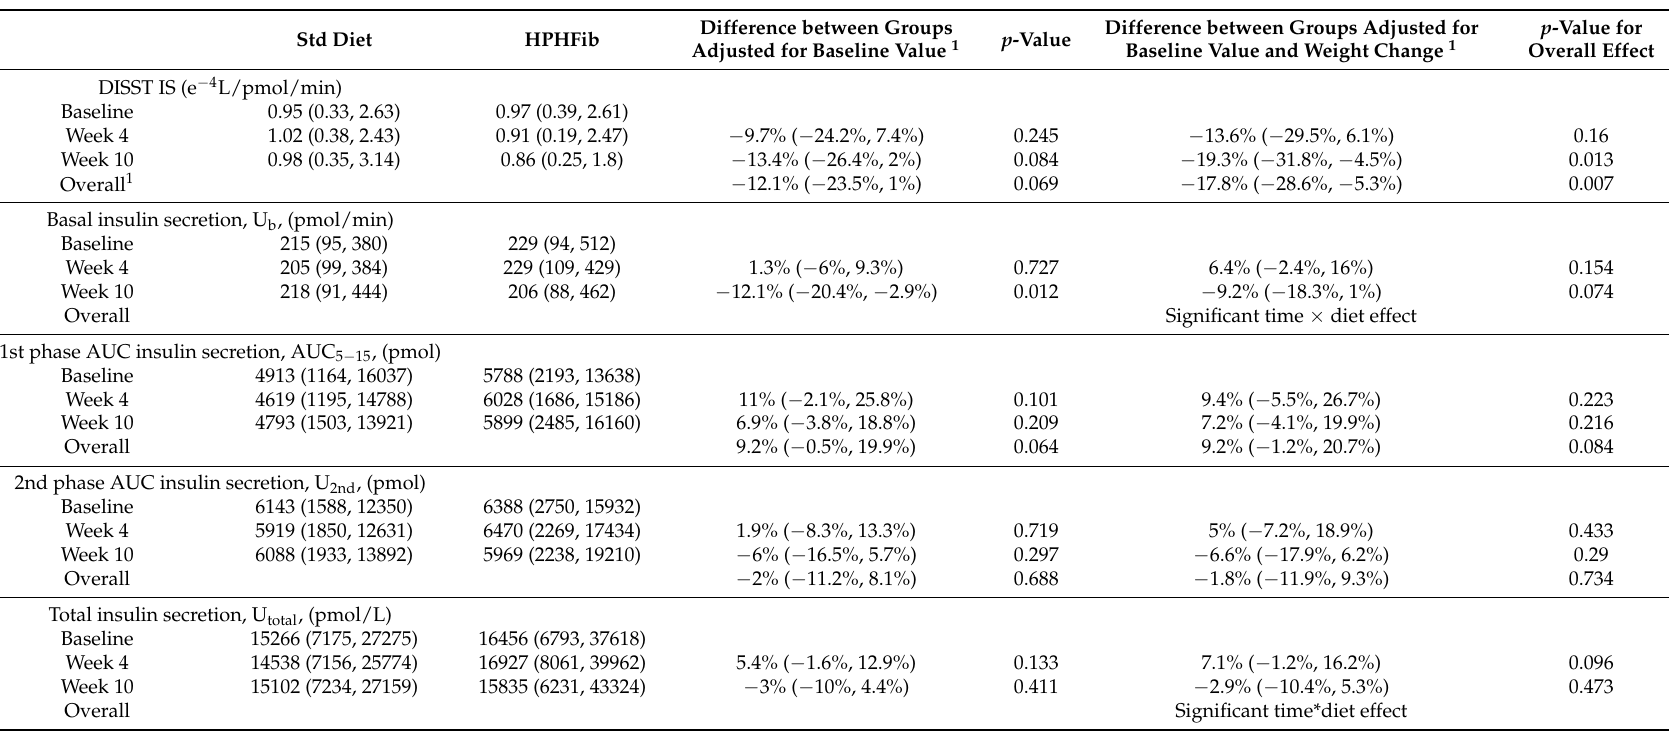
Table 4. Geometric mean (min, max) DISST measures of insulin sensitivity and secretion at baseline, week 4 and week 10 and percentage differences between dietary groups adjusted for baseline values and weight